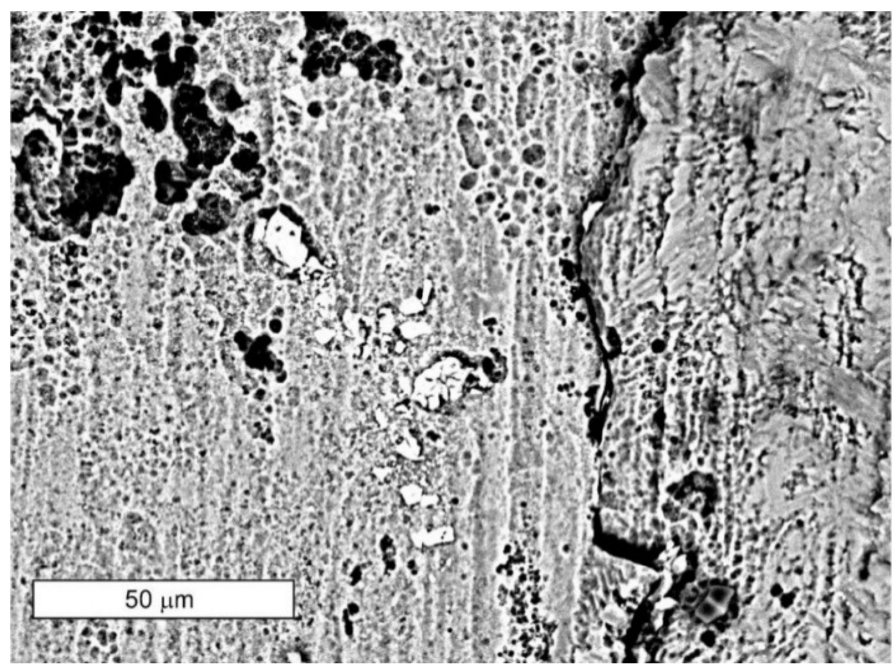
Figure 15. Corrosion developing in the area of grain boundaries and matrix in RRA state,